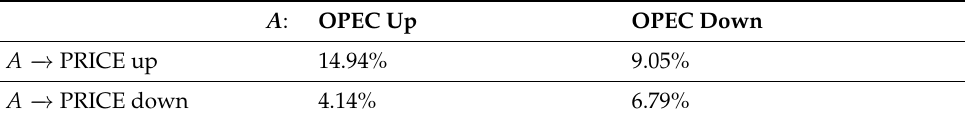
Table 8. TM for relation with OPEC −→